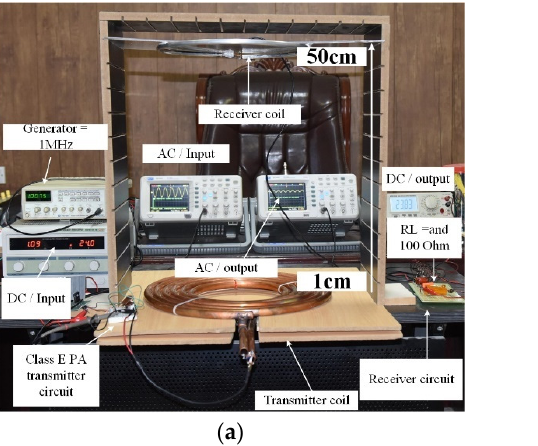
Table 5. Calculation of drone weight.